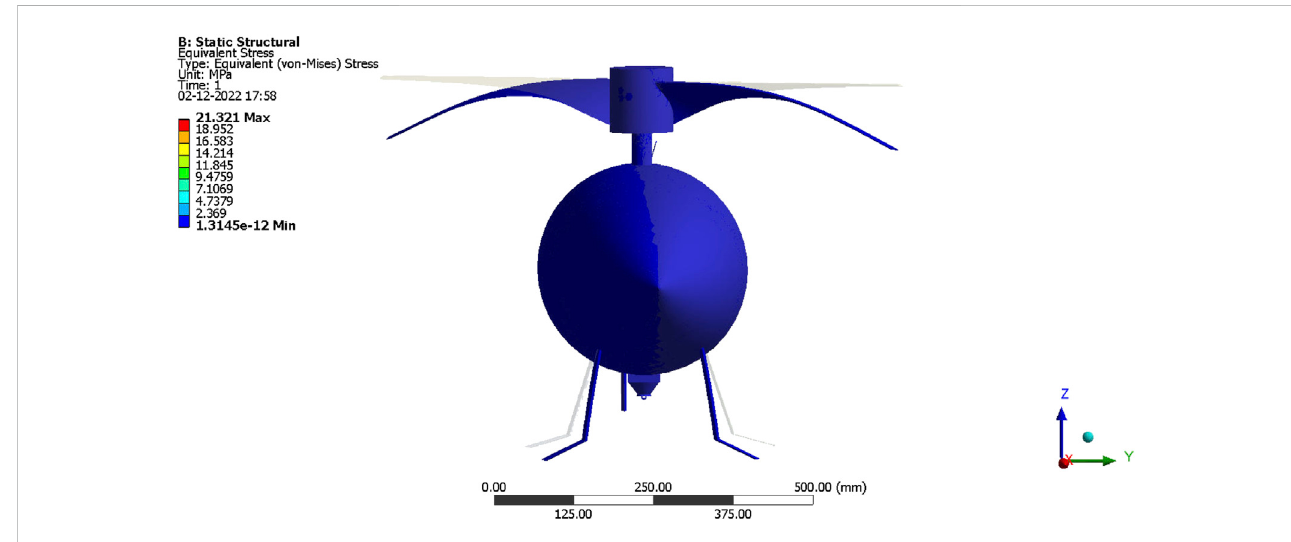
FR-4 based woven composite – equivalent elastic stress.